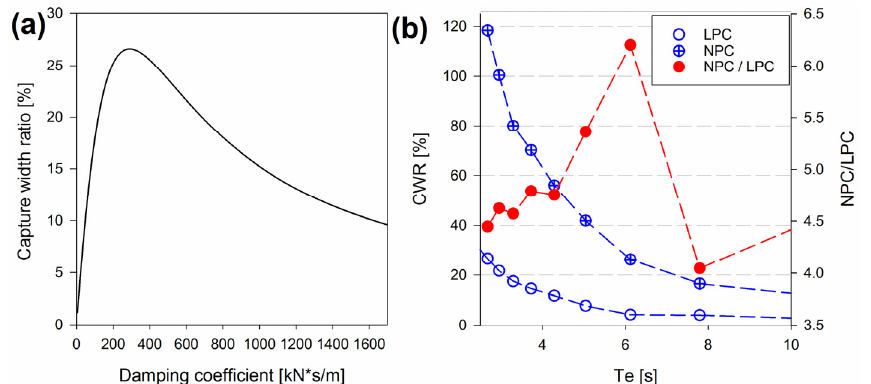
Figure 9. ( a ) Capture width ratio as a function of the damping coefficient with energy period (cid:1846) (cid:3404) 2.68 s ; ( b ) The comparison of the results under NPC and LPC. NPC/LPC is the ratio (cid:3032) between the CWRs from NPC and